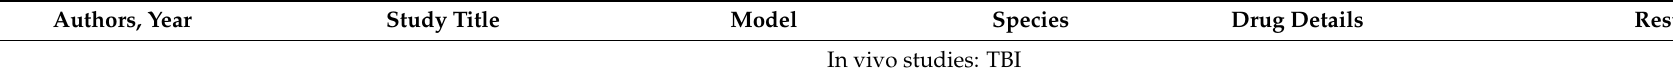
Table 4. Pre-clinical and clinical studies evaluating SUR1 inhibition for traumatic brain injury